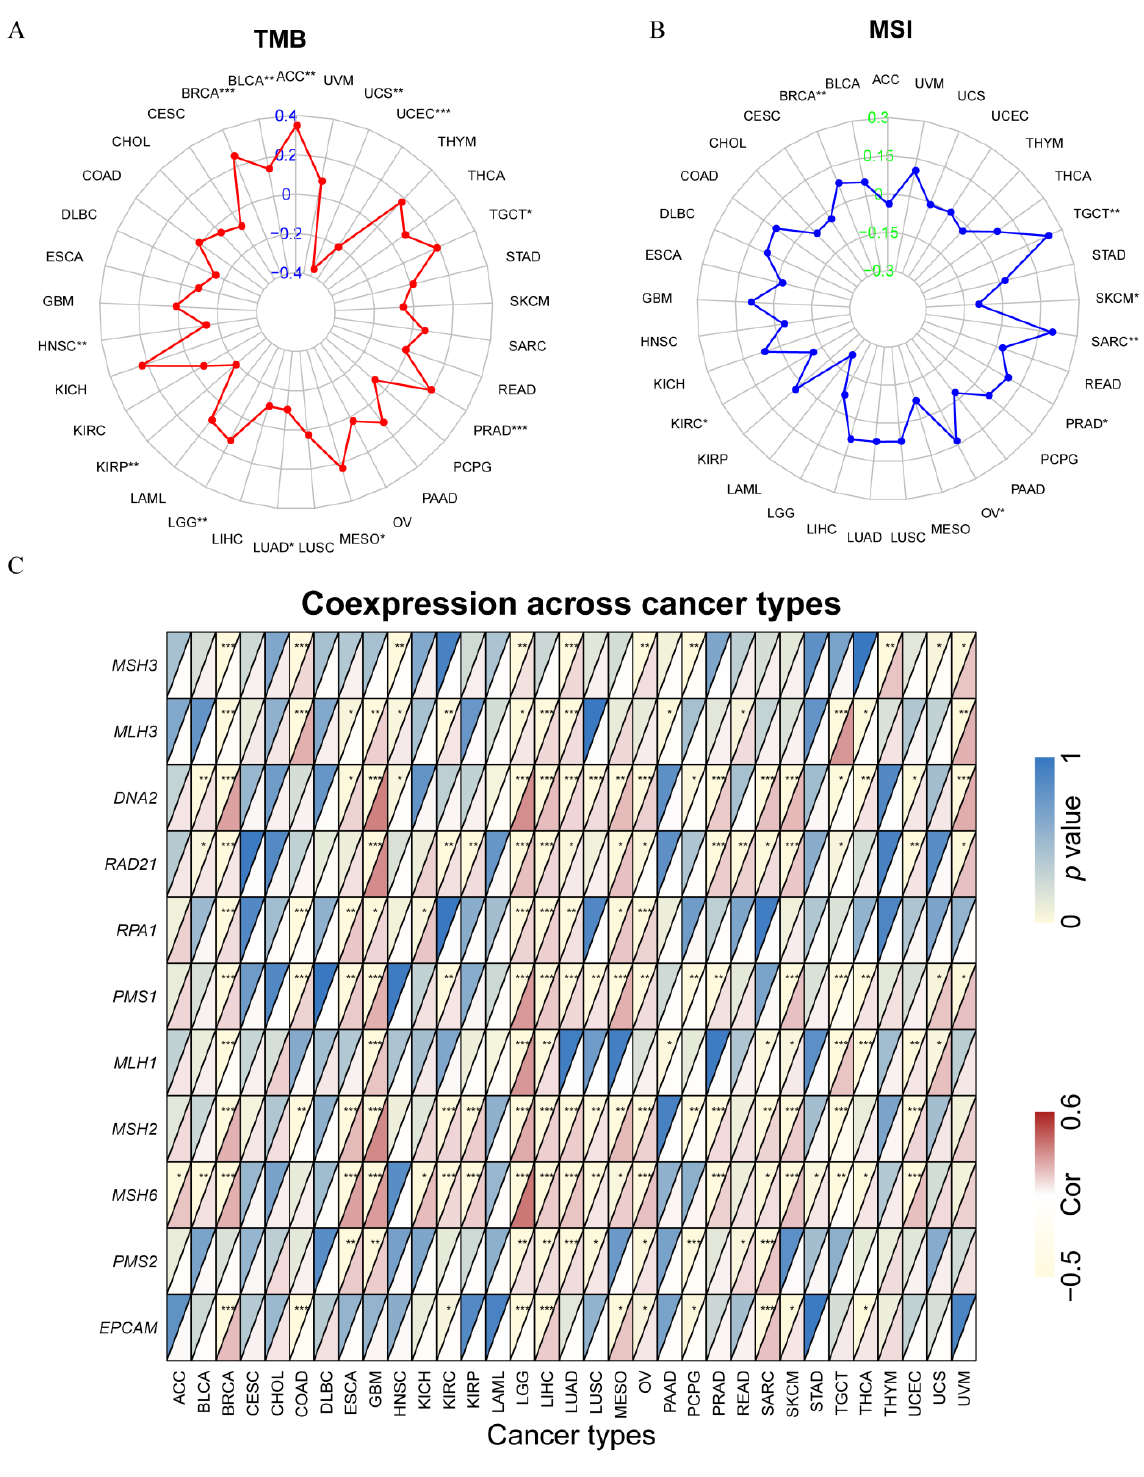
Figure 8. Analysis of the associations of SOX11 expression with TMB, MSI and MMR genes. ( A ) Radar map reflecting the correlation between the SOX11 expression and TMB. ( B ) Radar map reflecting the correlation between the SOX11 expression and MSI. ( C ) Correlation heatmap showing the relationship between SOX11 expression and MMR genes. For each pair, the top left triangle indicates the p-value, and the bottom right triangle denotes the correlation coefficient * p < 0.05, ** p < 0.01, and *** p < 0.001. Cor, correlation coefficient.